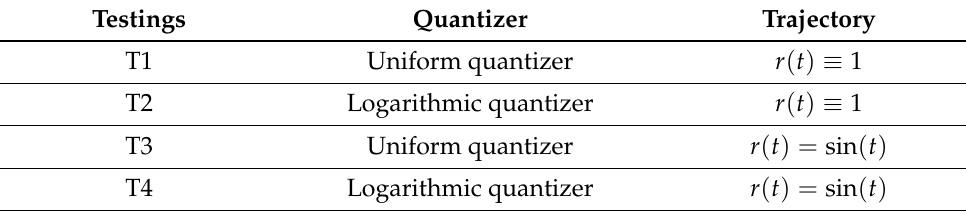
Table 5. Settings of the testings.